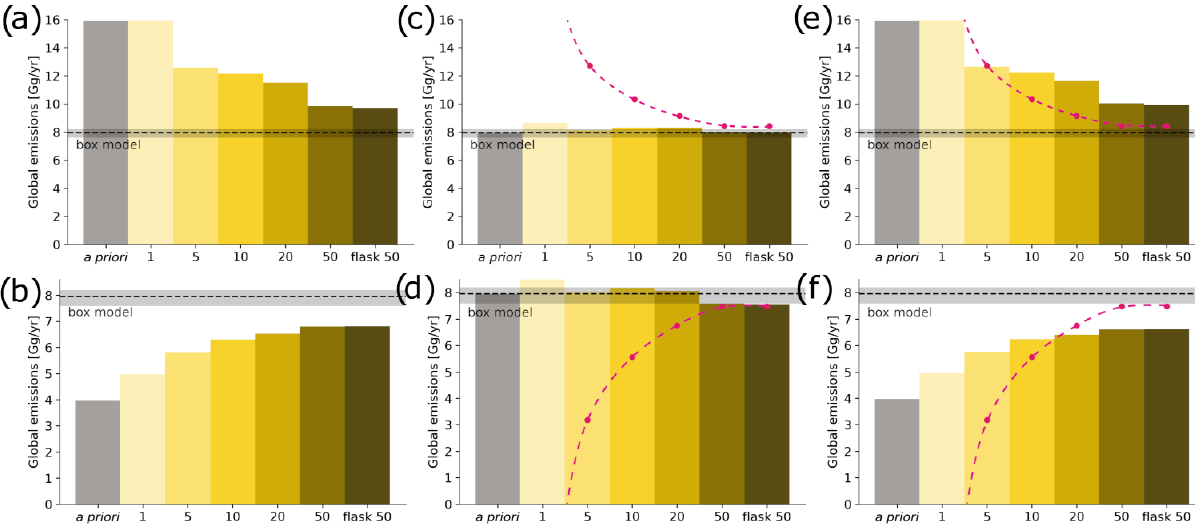
Figure 14. Global SF 6 emissions using the GDB method shown for different sensitivity cases, using backward simulation periods between 1 and 50d and a 50d backward simulation case in which flask measurements were also included in the inversion in addition to continuous measurements. The sensitivity cases include (a) doubled and (b) halved a priori emissions; biased global mixing ratio fields with a uniform bias of (c) − 0.003 and (d) + 0.003ppt in every grid cell; and combinations of the two test types; (e) doubled a priori emissions plus − 0.003ppt global field bias; (f) halved a priori emissions plus + 0.003ppt global field bias. The dashed pink lines represent the expected relationship between the baseline bias and a resulting emission bias if a global box model was used and the bias attributed solely to emissions in different periods corresponding to the backward simulation